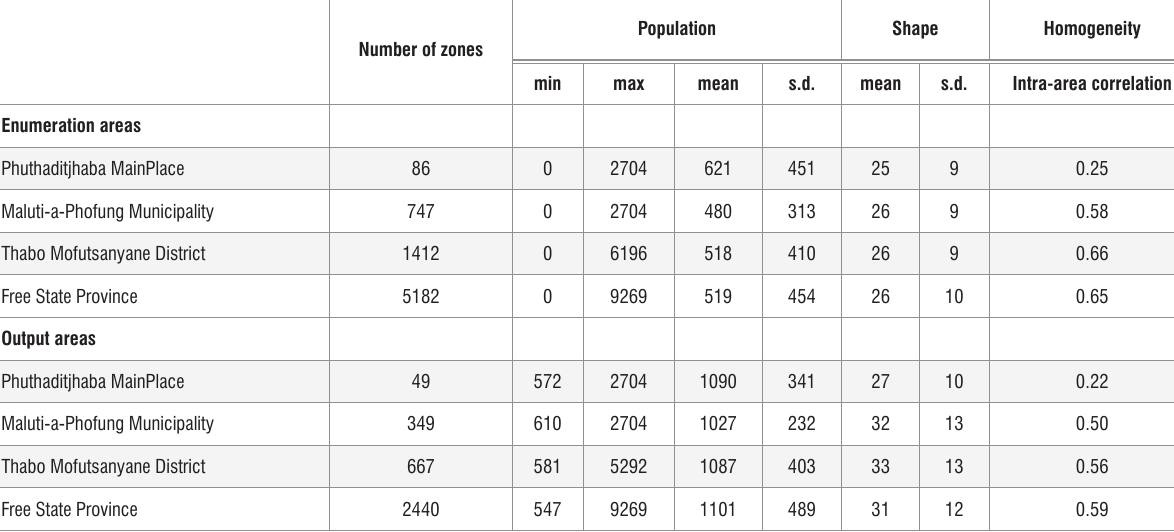
Table 2: Statistical characteristics of enumeration areas and output areas at various geographical levels for rural settings